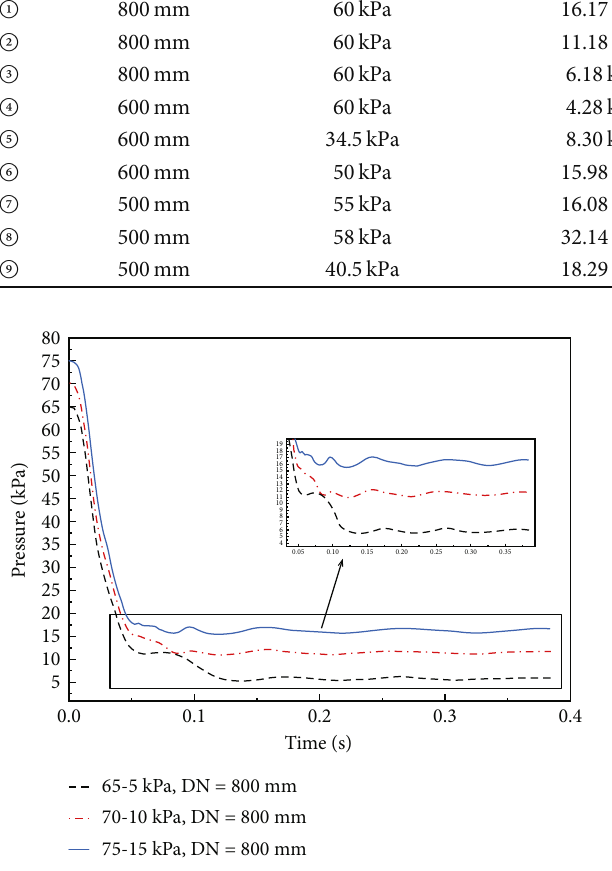
Figure 11: Rapid decompression and balancing process when DN = 800 mm